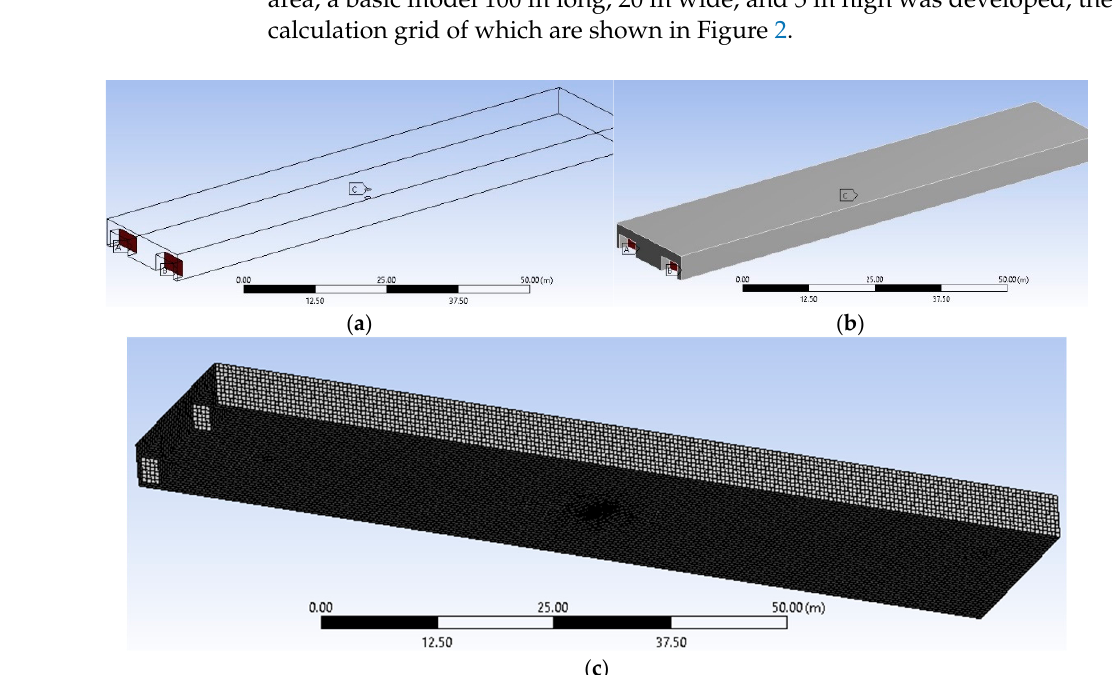
Figure 2. A principal model of the parking space for assessing the movement of air flow: ( a ) sketch and ( b ) visual model, ( c ) mesh view; A—outflow, B—inflow, C—inhalation of the respiratory system.